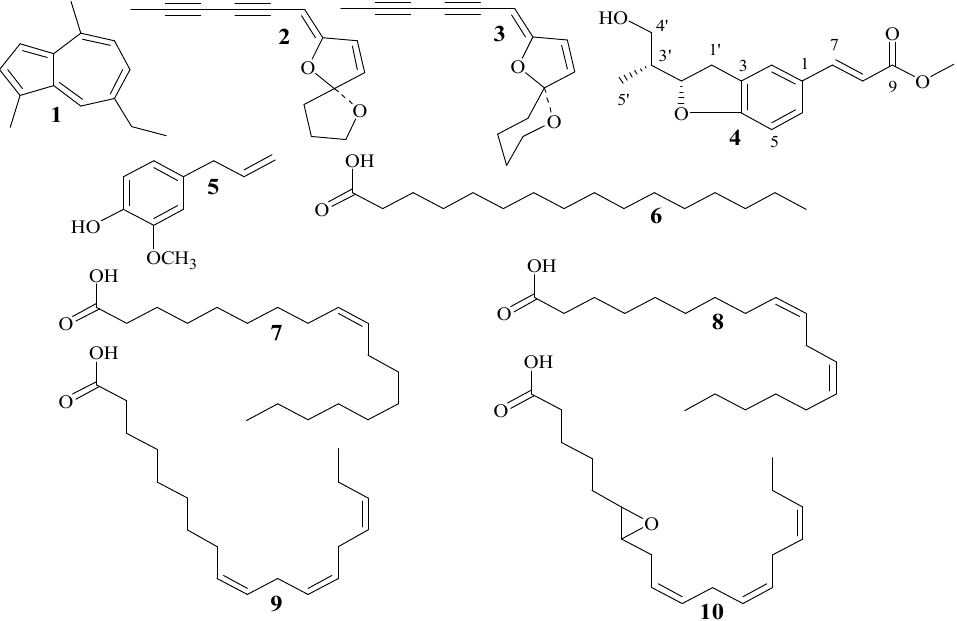
Figure 1. Structure of compounds 1 – 10 : chamazulene ( 1 ); acetylenes (E)-2 ( 2 ); acetylenes (E)-3 ( 3 ); integrinol ( 4 ); eugenol ( 5 ); palmitic acid ( 6 ); oleic acid ( 7 ); linoleic acid ( 8 ); linolenic acid ( 9 ); 12,13-epoxylinolenic acid ( 10 ).